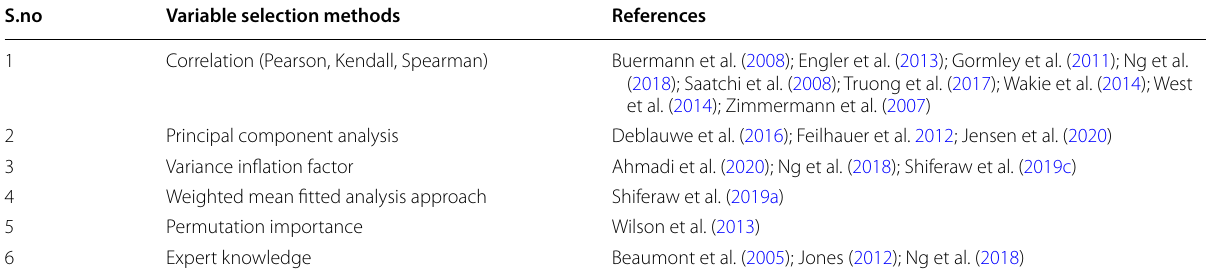
Table 2 Variable selection techniques used in the integration of remote sensing and bioclimatic based variables S.no Variable selection